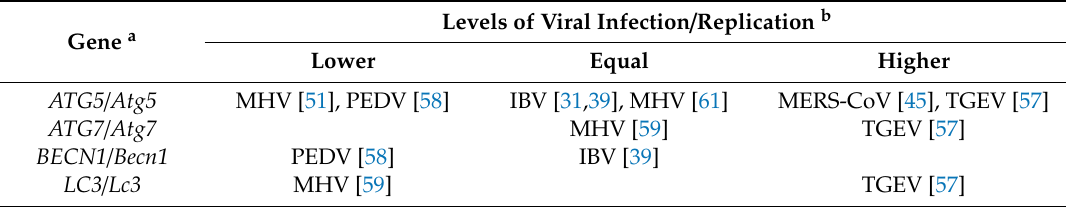
Table 3. E ff ect of the silencing of autophagy-essential elements on coronavirus replication. Levels of Viral Infection / Replication b Gene a Lower Equal Higher ATG5 / Atg5 MHV [51], PEDV [58] IBV [31,39], MHV [61] MERS-CoV [45], TGEV [57] ATG7 / Atg7 MHV [59] TGEV [57] BECN1 / Becn1 PEDV [58] IBV [39] LC3 / Lc3 MHV [59] TGEV